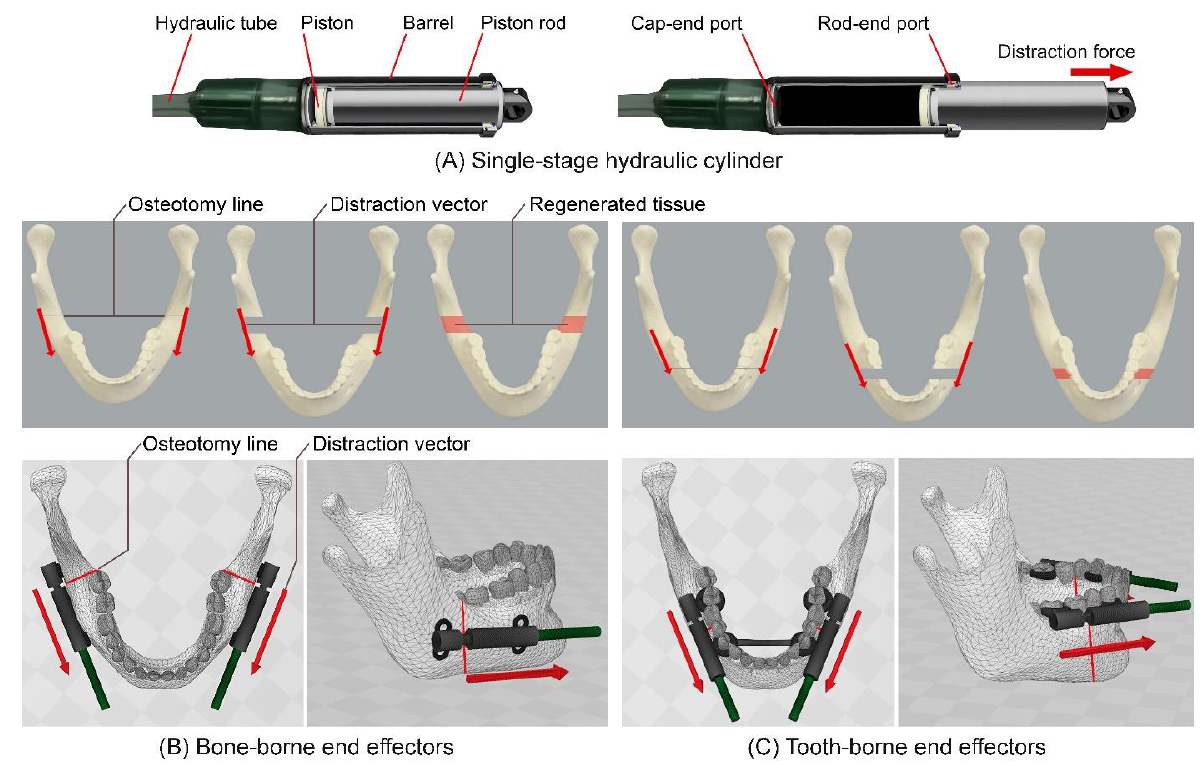
Figure 7. Intra-oral single-stage cylinder, and BB and TB end effectors for different MRAs: ( A ) intra-oral hydraulic cylinder; ( B ) BB end effectors; ( C ) TB end effectors.